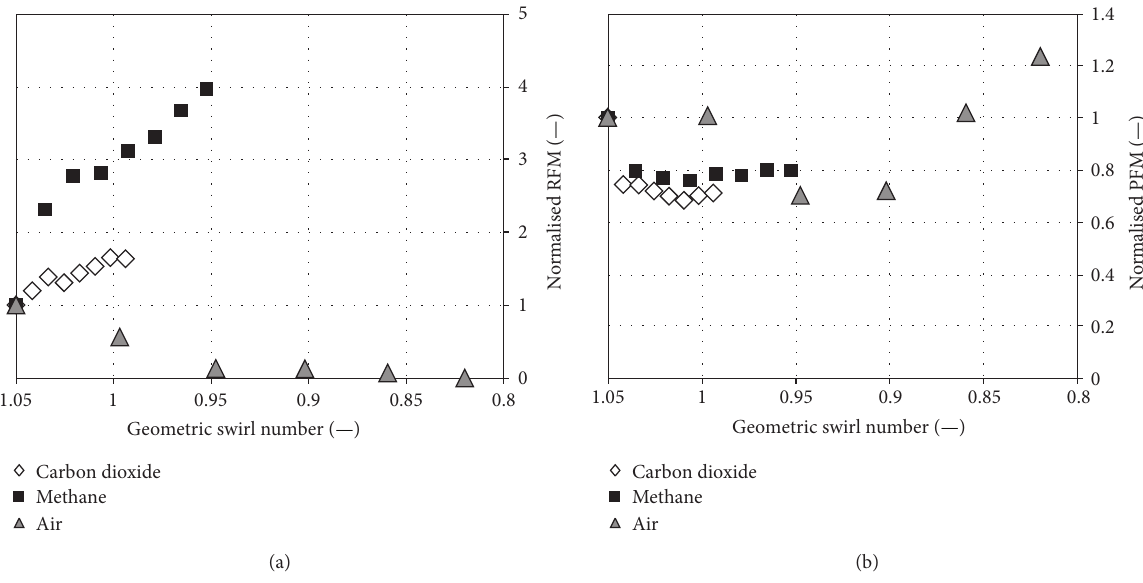
Figure 9: The (a) reverse and (b) positive flow momentum for all test points at 𝑦/𝐷 = 0.5